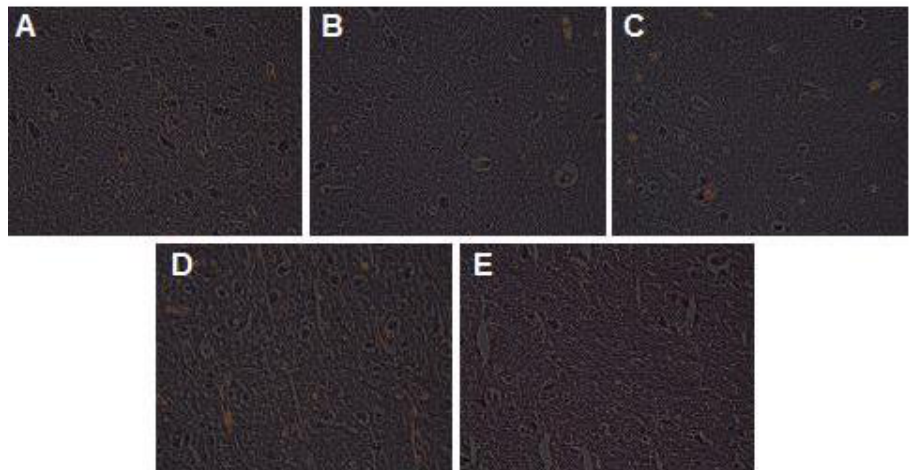
Figure 4. Representative microscopic findings in brain of ovariectomized (OVX) rats treated with yeast hydrolysate (YH) for 8 weeks (hematoxylin-eosin stain, × 400). ( A ) Sham: sham operation; ( B ) Control: no treatment after OVX; ( C ) Estrogen: estrogen treatment after OVX; ( D ) YH, 0.5%: drinking water supplementation with 0.5% YH after OVX; ( E ) YH, 1%: drinking water supplementation with 1% YH after OVX. YH 0.5% and 1% in drinking water are equivalent to a dose of 1 and 2 g· kg ­ 1 BW, respectively, based on daily water consumption.